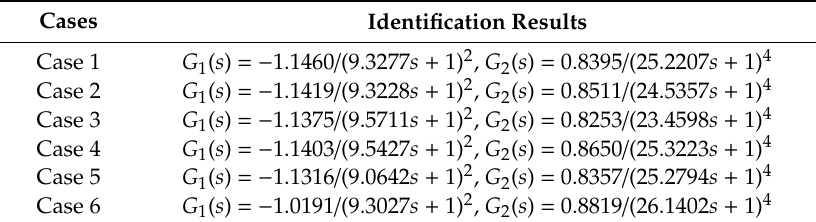
Table 7. Identification results of different optimization cases.